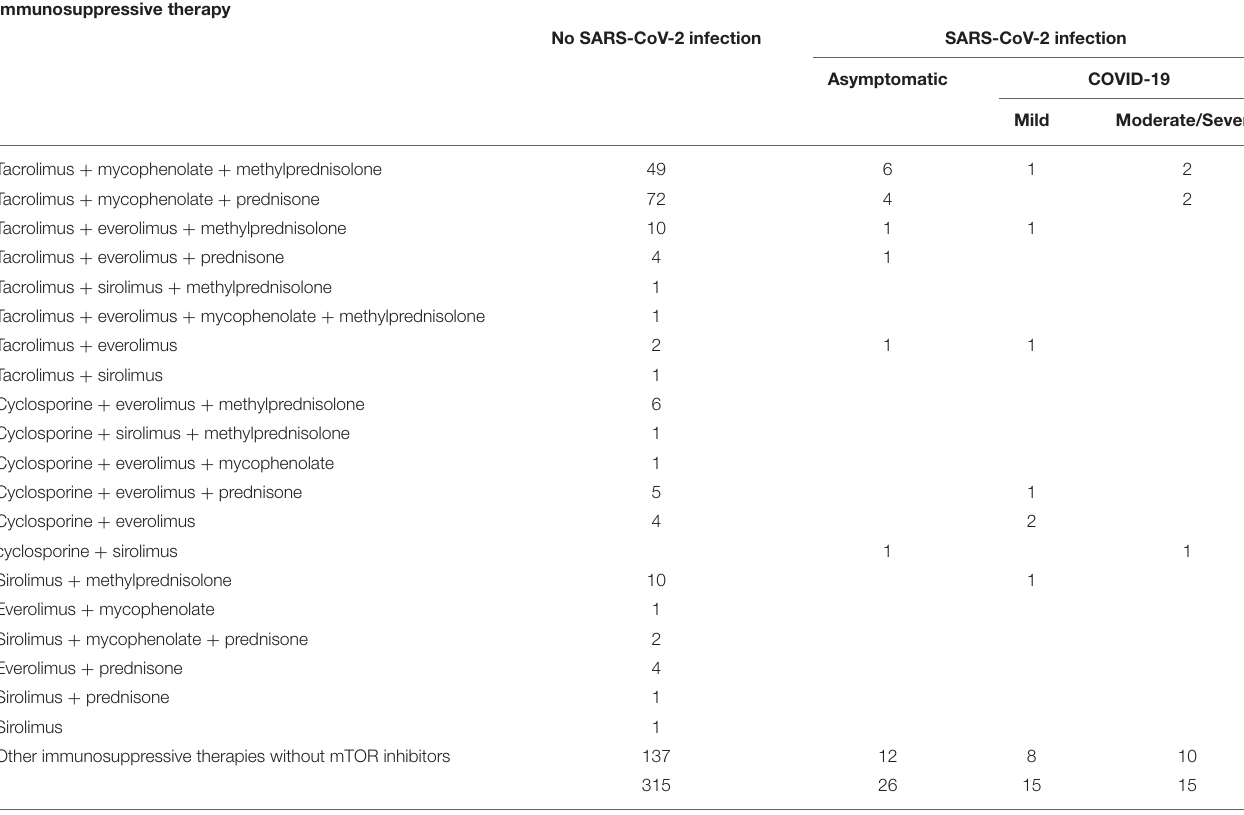
TABLE 2 | Immunosuppressive therapy for each patient. Immunosuppressive therapy